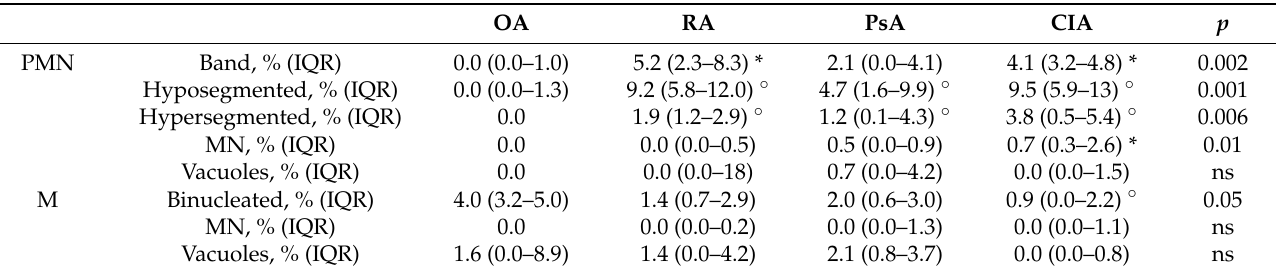
Figure 1. Cytogenic and cellular morphology evaluation of SF leucocytes. Synovial fluid smears were stained using MGG staining. ( A ) Band PMN, ( B ) hyposegmented PMN, ( C ) hypersegmented PMN, ( D ) MN, ( E ) cells with vacuoles, ( F ) binucleated. PMN, polymorphonuclear cells; M, monocytes; L, Lymphocytes; MN, micronucleus. Table 2. Cytogenic and cellular morphology evaluation of PMN and M in SF from OA (n = 7), RA (n = 6), PsA (n = 12) and CIA (n = 10) patients.